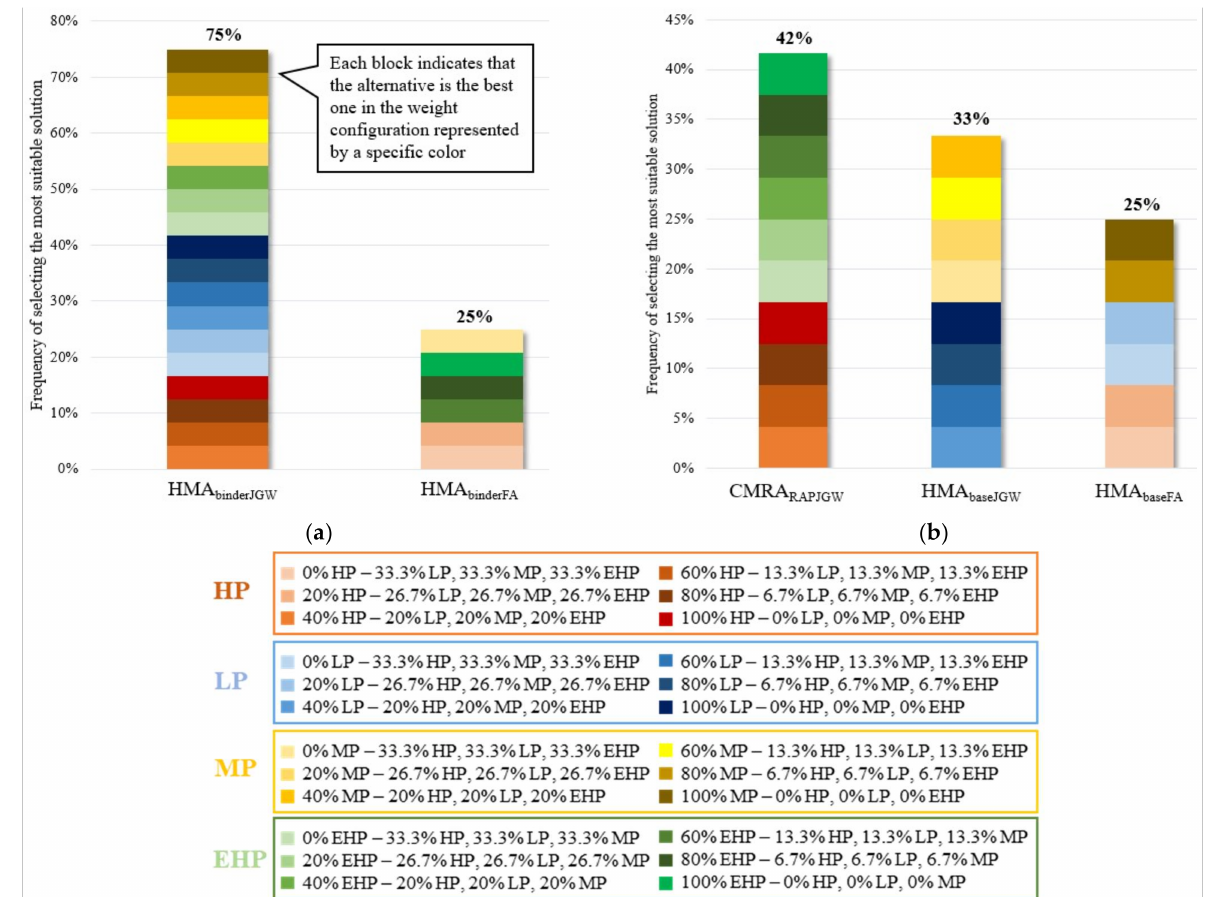
Figure 4. Sensitivity analysis results that identified the best solutions for each weight configuration of the ( a ) binder and ( b ) base asphalt